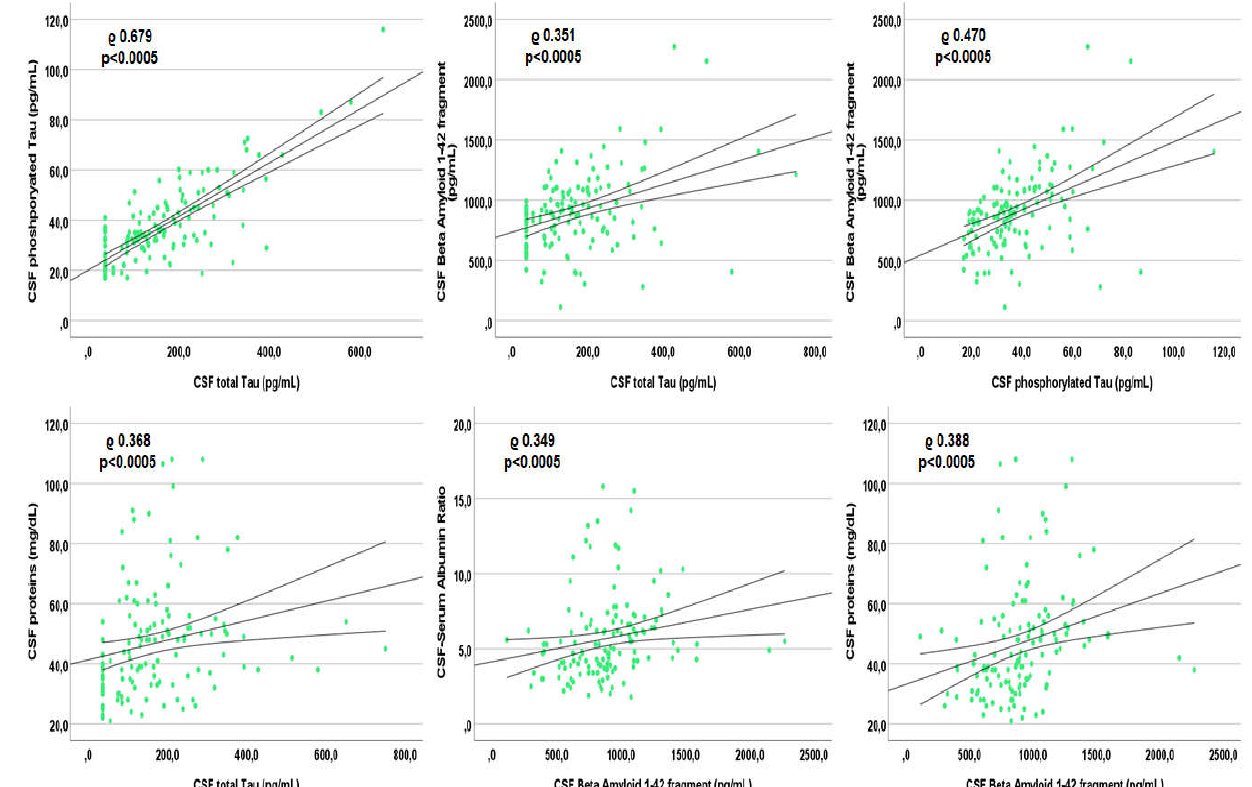
Figure 3. Spearman’s correlations between each other Alzheimer’s dementia biomarker and other markers within the cerebrospinal fluid of patients with undetectable plasma viremia.